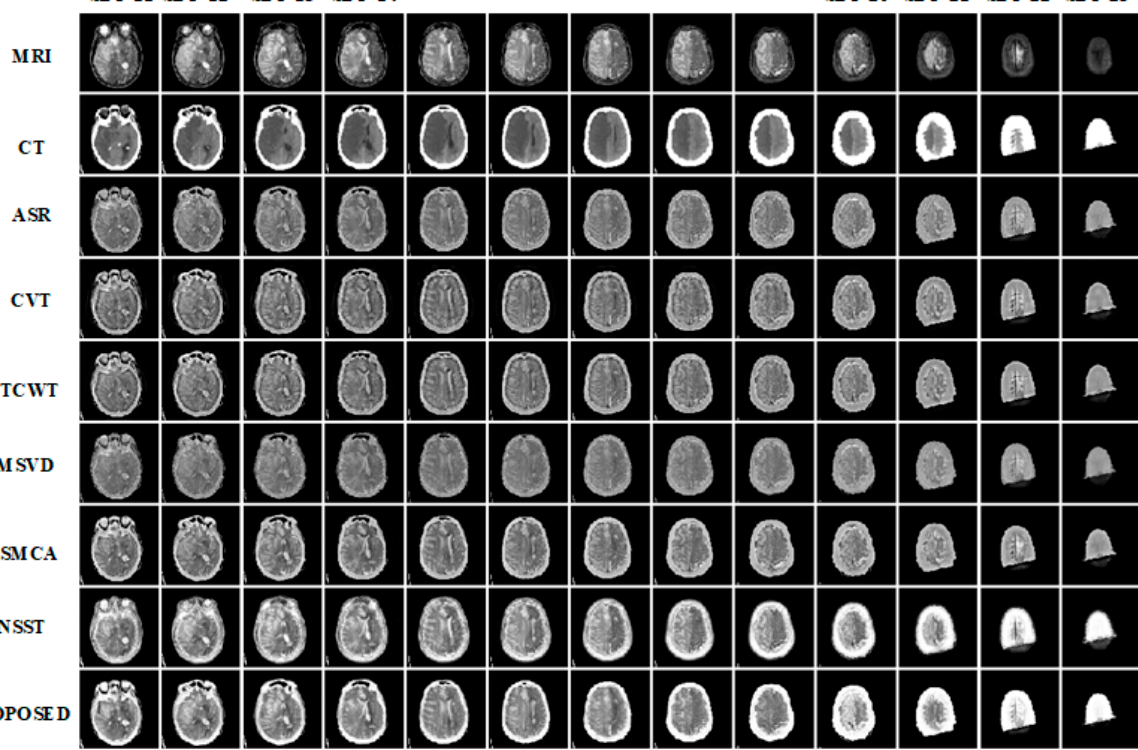
Figure 9. The results of various methods on next 13 pairs of MRI-CT images (fatal stroke).